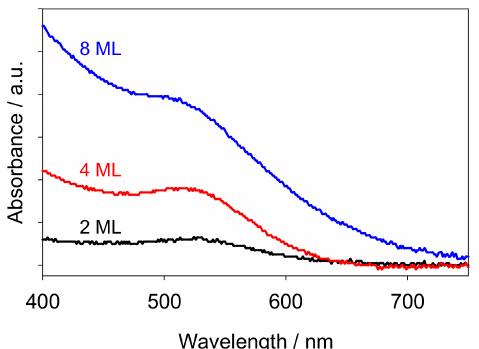
Figure 2. UV-Vis absorption spectra of 2 ML (black), 4 ML (red) and 8 ML (blue) AuNCs on TiO 2 films, with a pristine TiO 2 film as the background